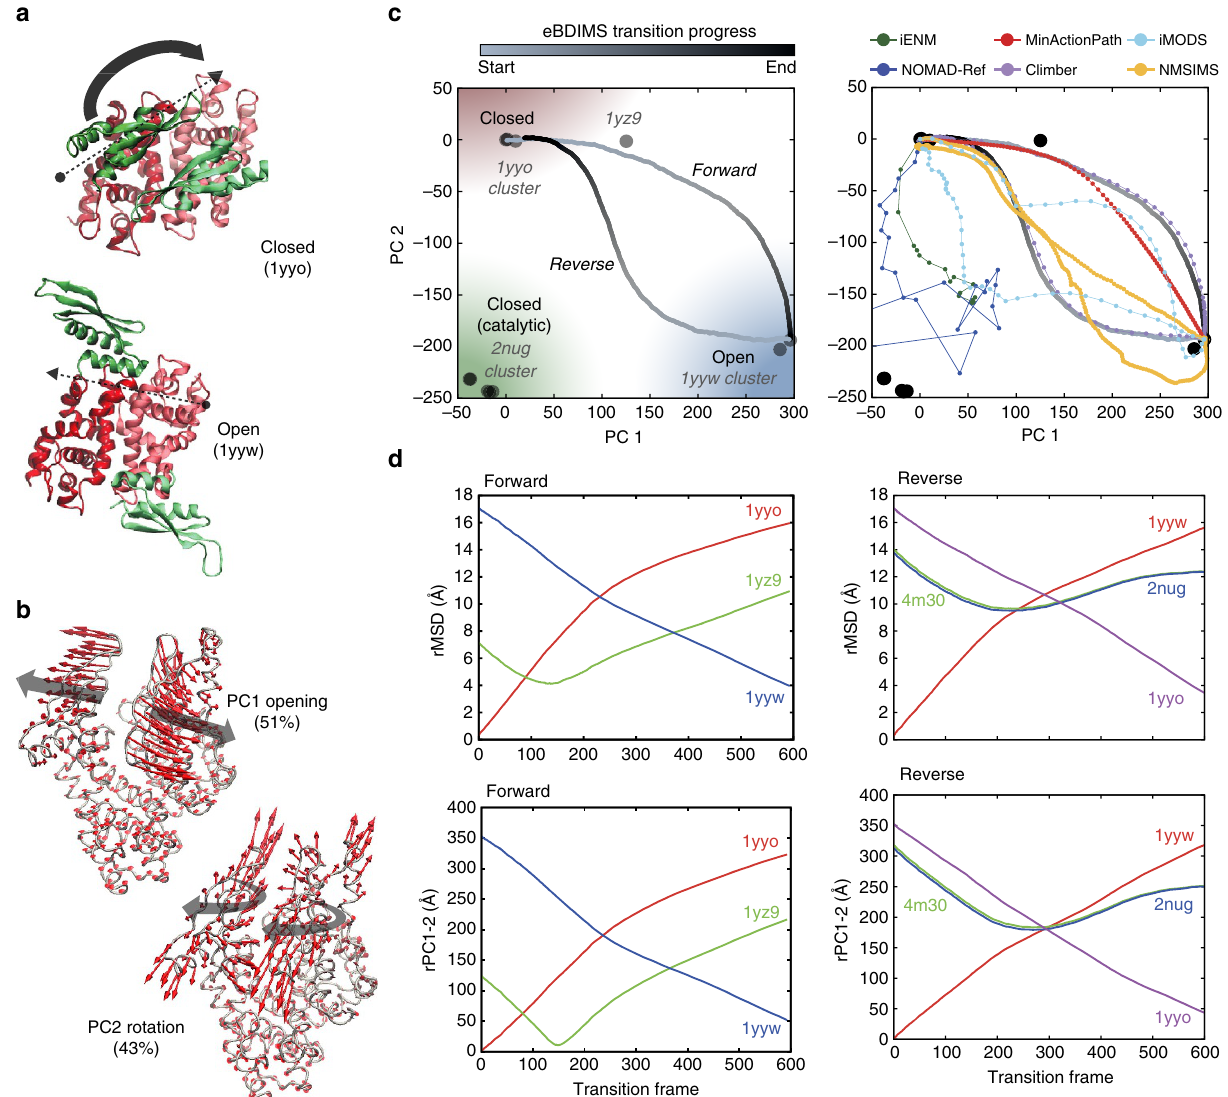
Figure 4 | Conformational transition of A. aeolicus RNA endonuclease III (RNaseIII). ( a ) Crystallographic dimers for closed non-catalytic state (1yyo) and open pre-catalytic state (1yyw), showing the dsRNA-binding domains (RBDs) in green and the rest of the protein in red surface; both structures are bound to dsRNA and represent different stages in re-orienting the substrate for catalysis. ( b ) Dominant PCs of the X-ray ensemble (11 structures) track RBD arms separation and rotation versus the reference 1yyo structure. ( c ) Left: projections of the ensemble and the eBDIMS trajectories onto the PC1-2 subspace reveal an hysteresis-like cycle with a tight sequence of concerted motions; PC1-2 separate the crystal structures into four clusters (shown as red (closed non-catalytic), white (intermediate), blue (open pre-catalytic) and green (closed catalytic) regions). Right: comparison between the forward pathways computed by eBDIMS, iENM, NOMAD-Ref, MinActionPath and Climber. Reverse pathways generated by eBDIMS, iMODS, NMSIM and Climber also shown. ( d ) rMSD and PC1-2 distance between the forward (left) and reverse (right) trajectories and the crystallographic intermediates